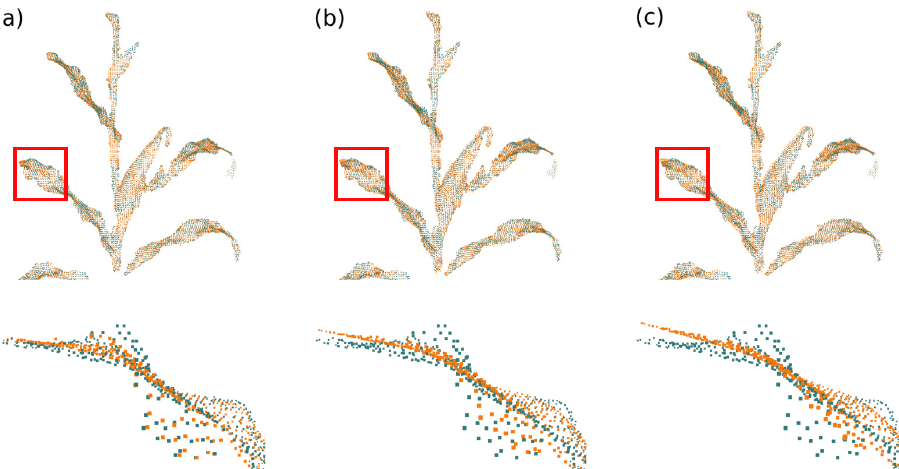
Figure 8. Point cloud smoothing. The orange point cloud indicates the smoothed point cloud, with ( a ) one iteration; ( b ) two iterations and ( c ) three